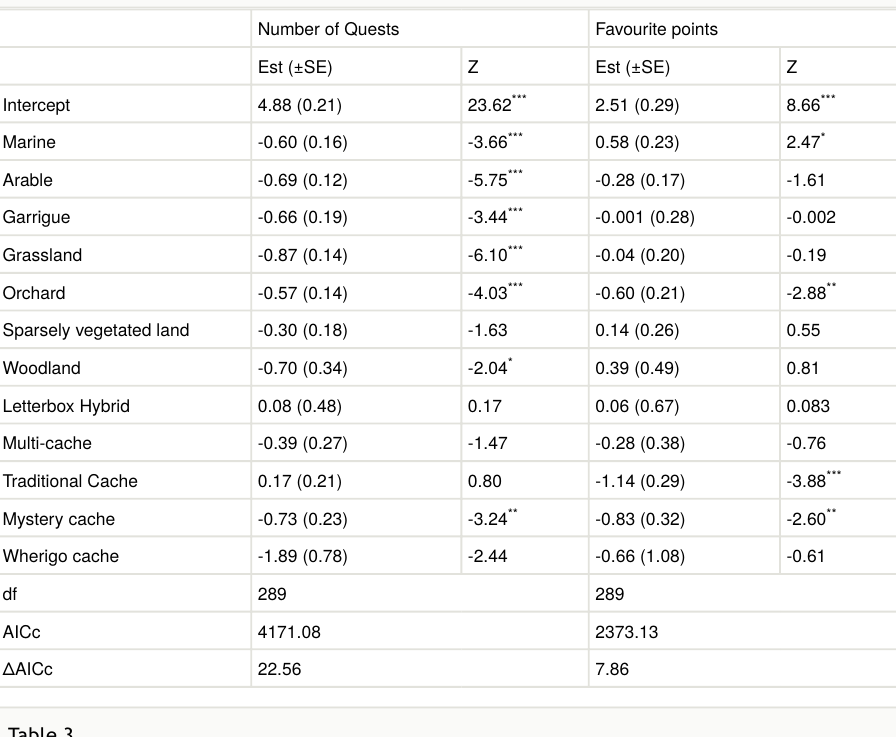
Association of the geocaching number of quests and favourite points from the study area with the reclassi fi ed Urban Atlas categories, obtained from GLMM with a negative binomial error distribution and using the number of years from geocache placement as an o ff set in the analysis and geocache type as a random variable. Estimated parameters (Est) and Wald test values (Z) from the GLMM, when compared to the Urban - High Density category, are shown. 0.05<P<0.1,